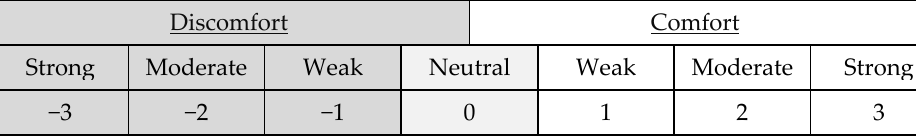
Figure 4. General comfort